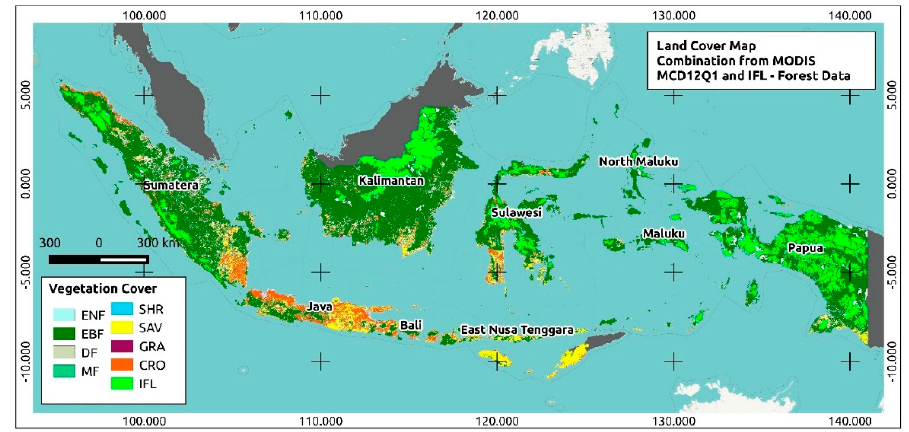
Figure 1. Vegetation cover types in Indonesia based on combined MODIS MCD12Q1 and IFL data (see Materials and Methods section for details) with 1 × 1 km spatial resolution.